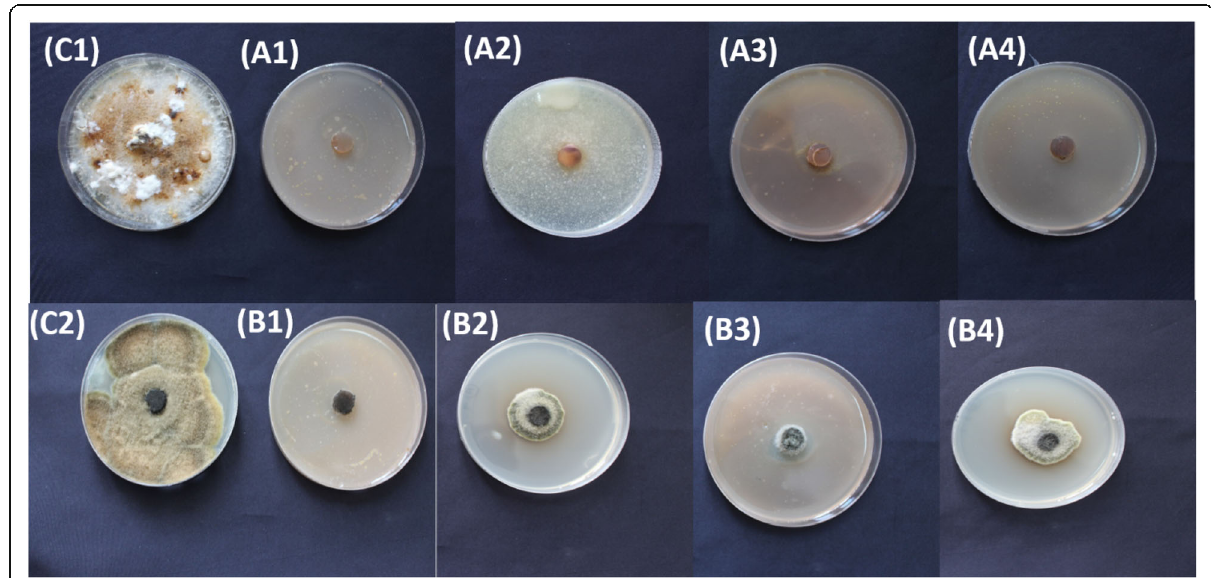
Fig. 3 Inhibition of mycelial growth of F. solani and Alternaria sp. by cell-free culture supernatants of endophytic bacterial strains (C1 and C2, control for F.solani and Alternaria , respectively; A1 – A4, F. solan i exposed to B1, B7, B8 and B9: B1 – B3, Alternaria sp. exposed to B1, B7, B8 and B9)